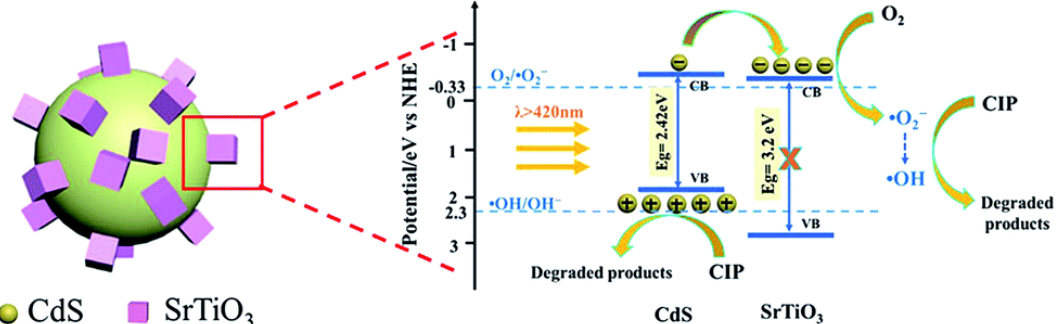
Figure 15. Photocatalytic degradation mechanism of ciprofloxacin over CdS/SrTiO 3 heterojunction under visible light [118]